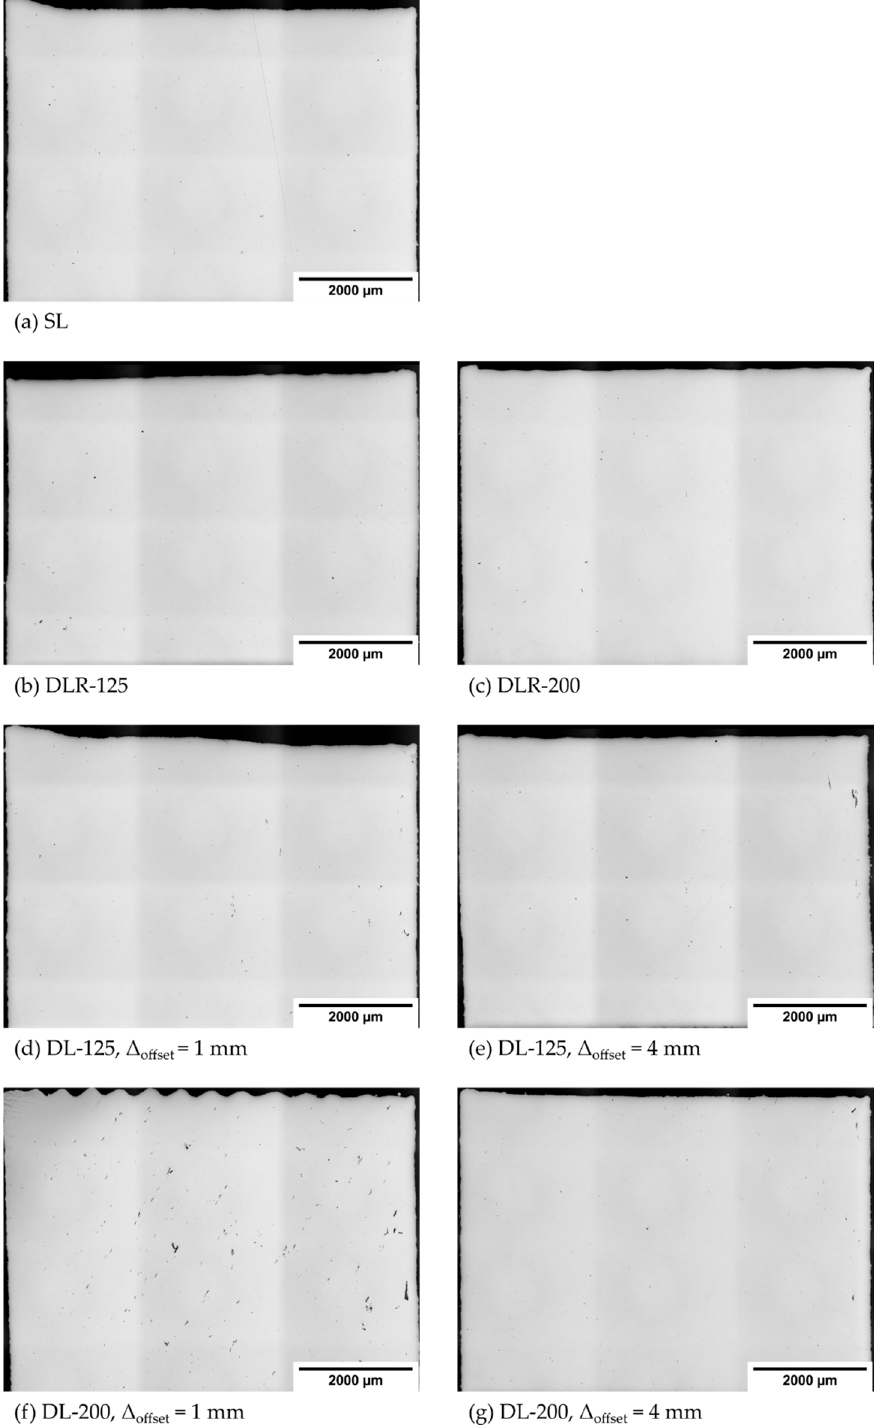
Figure 9. Resulting cross-sections for material density measurements of the parameter sets ( a ) SL, ( b ) DLR-125, ( c ) DLR-200, ( d ) DL-125 with ∆ offset of 1 mm, ( e ) DL-125 with ∆ offset of 4 mm ( f ) DL-200 with ∆ offset of 1 mm and ( g ) DL-200 with ∆ offset of 4 mm.